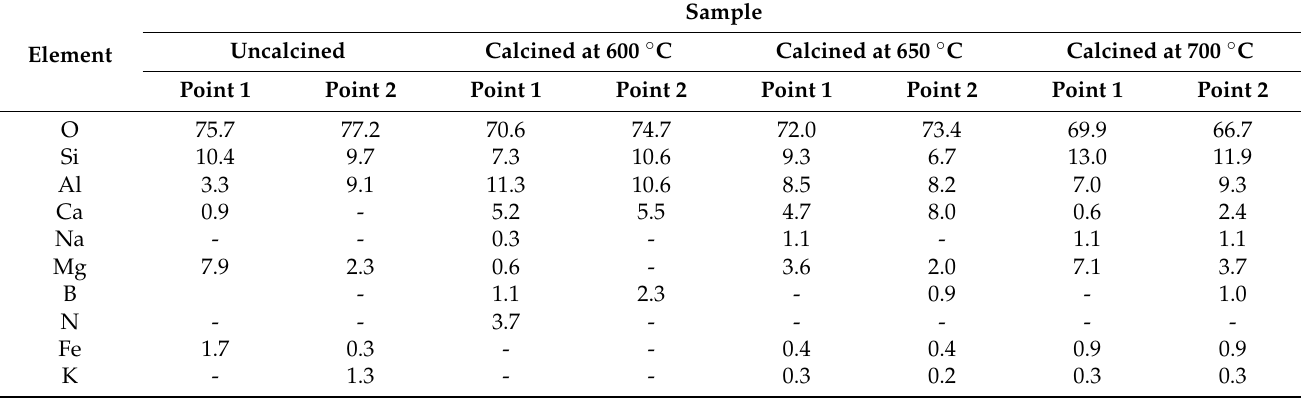
Table 4. EDX analysis of ceramic papers calcined at different temperatures (Figure